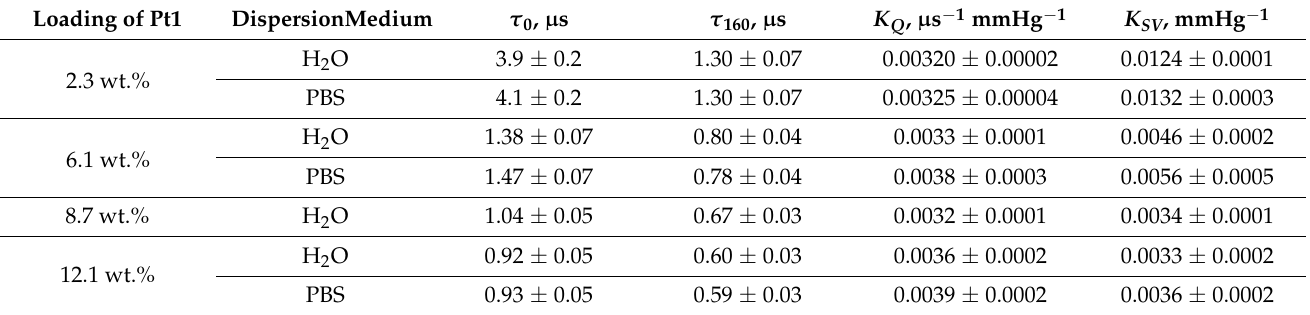
s; τ 0 = 3.9 ± 0. 2 µ s) to approx. 1.5 Table 1. The corresponding Stern–Volmer plots were linear for all micellar compositions (Figure 3A). Stern–Volmer constants ( K SV ) display values from 0.0033 ± 0.0002 mmHg − 1 ( Pt1 loading: 12.1 wt.%) to 0.0124 ± 0.0001 mmHg − 1 ( Pt1 loading: 2.3 wt.%) in Table 1. K SV values strongly depend on Pt1 loading and level off above the compositions of 9 wt.% Pt1 ,